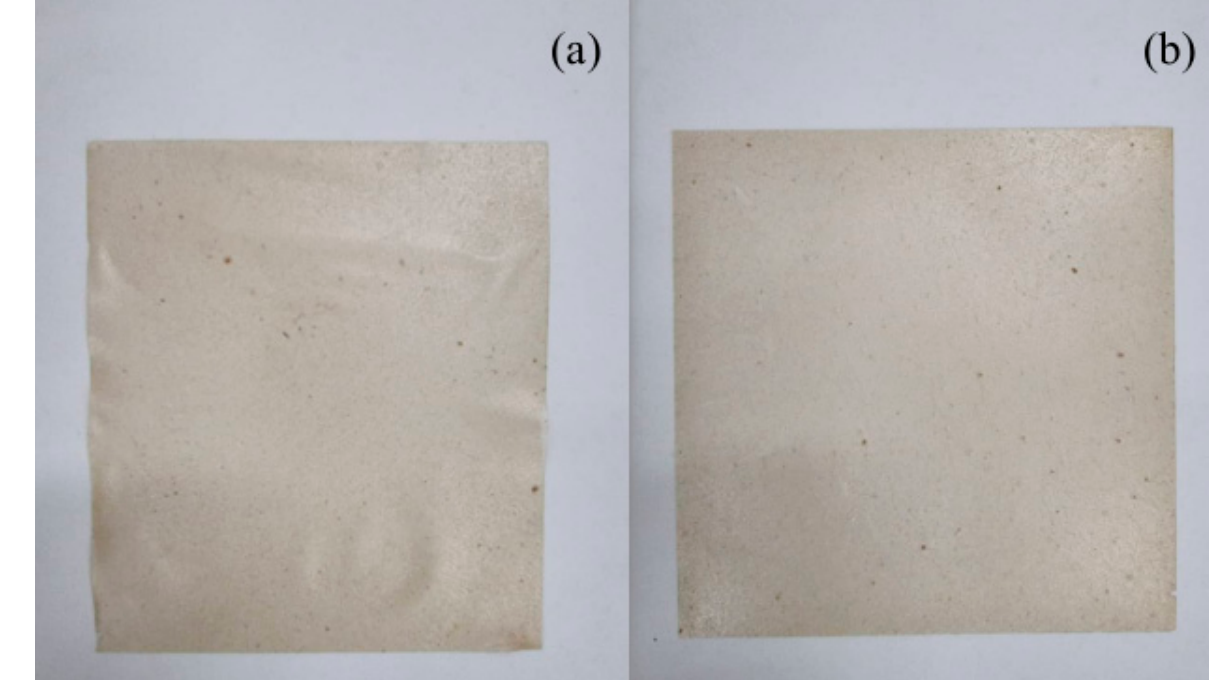
Figure 8. Photographs of film fabricated using ( a ) control starch and ( b ) ultrasound-extracted starch.